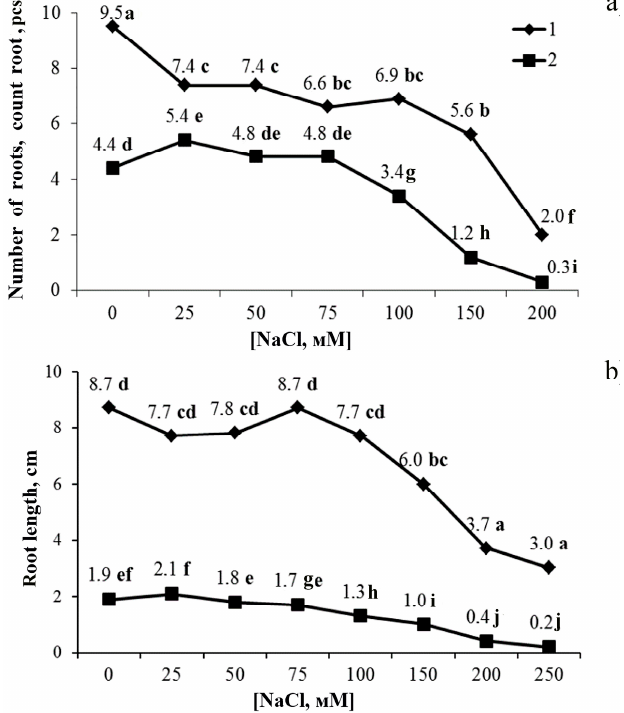
Figure 1. Effect of different concentrations of NaCl in the nutrient medium for rhizogenesis induction on the number of regenerated roots and their length in tomato seedlings of the YaLF line ( a ) and cv Recordsmen ( b ). Means followed by the same letter are not significantly different at α = 0.05 according to Duncan’s multiple range test.